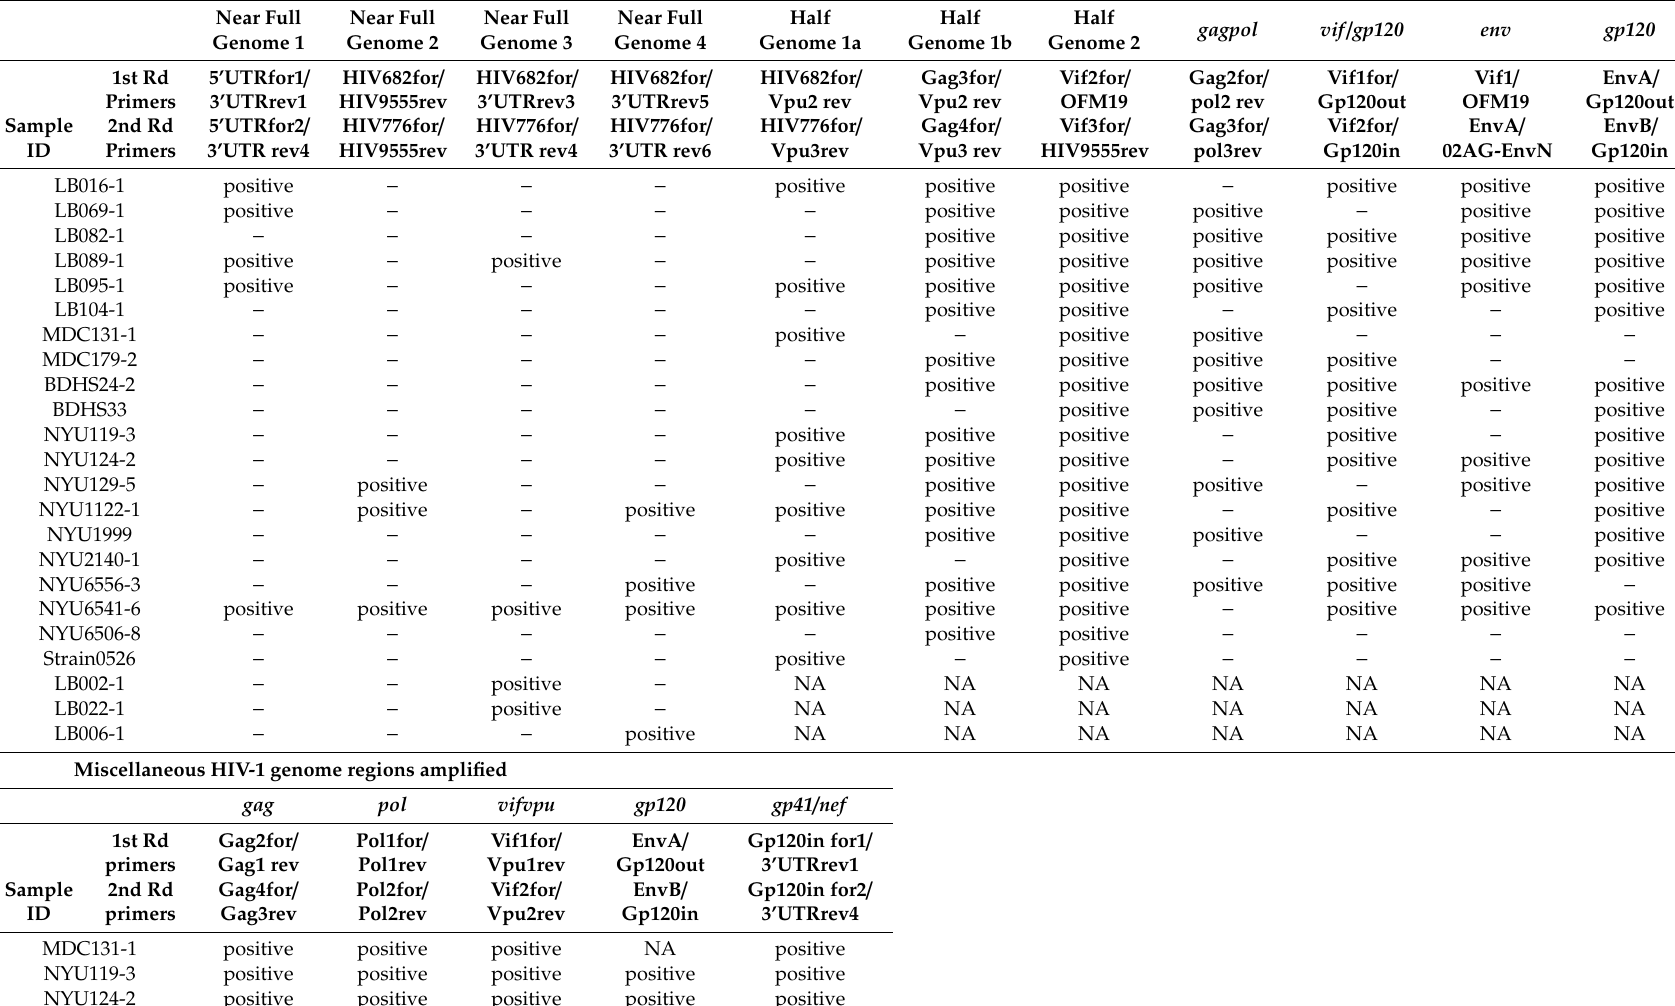
Table 4. Summary of amplification approaches and yield using 23 pure or recombinant HIV-1 samples. Near Full Genome